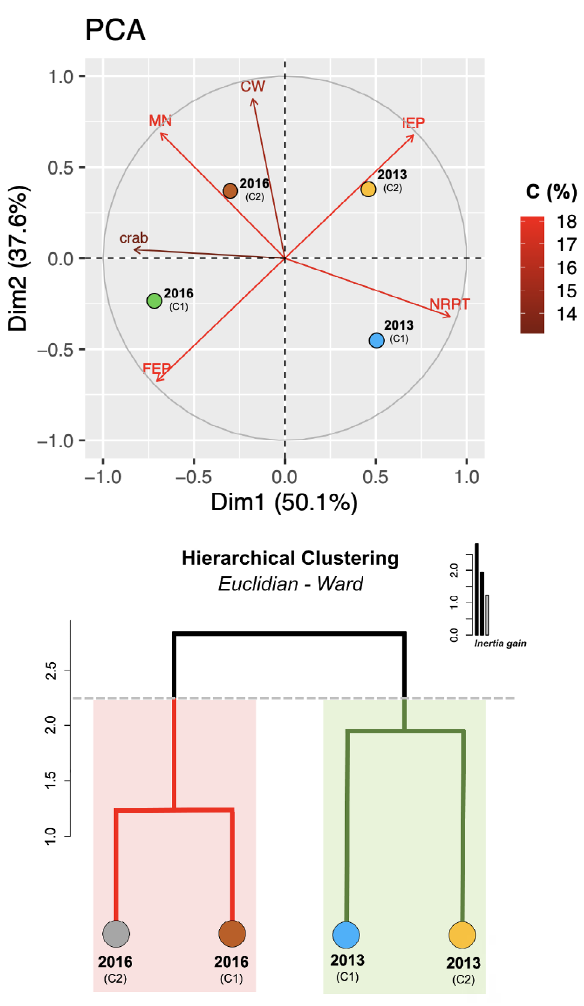
Figure 3. Principal Component Analysis (PCA) using a biplot function, with the percentual contribution (C) of each variable; and Hierarchical Clustering of similarity expressed by a dendrogram using the Euclidian metric and Ward method. A total of six variables based on ‘uçá’-crab ( Ucides cordatus ) were used, in two mangrove areas (C1 and C2) at Cubatão municipality, bracketing an environmental disaster (2013: pre- disaster; and 2016: post-disaster). Where: CW, carapace width (mm); crab, population density (ind./m 2 ); FEP, future extractive potential; IEP, immediate extractive potential; MN, frequency of micronucleated cells (micronucleated hyalinocyte cells/1,000); and NRRT, neutral red retention time